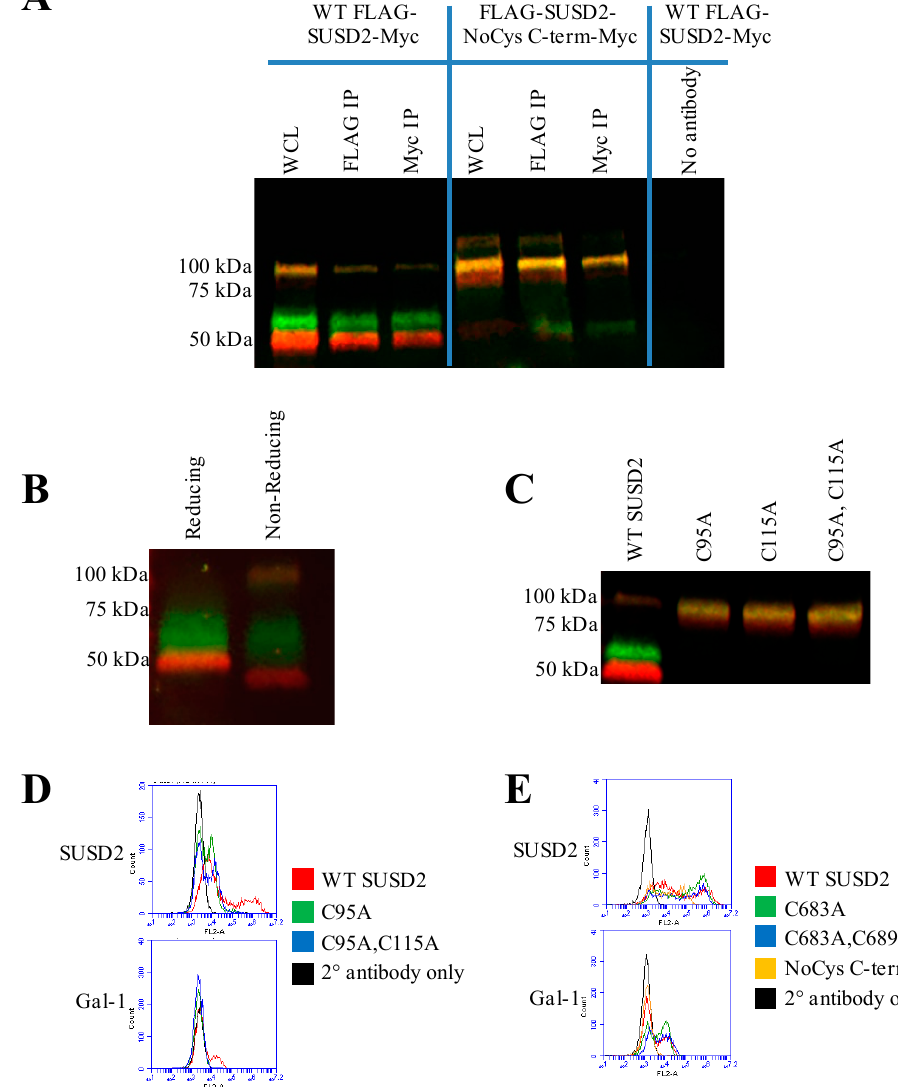
Figure 5. Immunoprecipitation and flow cytometry analysis of FLAG-SUSD2-Myc. ( A ) 293T cells were transfected with either pFLAG-SUSD2-myc or pFLAG-SUSD2-NoCys C-term-myc. Whole cell lysates (WCL) were immunoprecipitated with anti-FLAG or anti-Myc antibodies. Western immunoblot analysis using anti-N-terminal (red) and anti-C-terminal (green) SUSD2 antibodies was performed. Yellow indicates the presence of the full-length SUSD2 polypeptide. WCLs were used as a positive control. ( B ) SUSD2 precursor polypeptide present under nonreducing conditions. Western immunoblot analysis of SUSD2 from SKBR3 WCL was performed under reducing and nonreducing conditions. For nonreducing conditions, β -mercaptoethanol was omitted from the loading bu ff er. Antibodies used for western immunoblot analysis are the same as above in ( A ). ( C ) SUSD2 C-terminal cysteine to alanine mutations inhibited cleavage. Western immunoblot analysis was performed on 293T cells transiently transfected with plasmids encoding FLAG-SUSD2-Myc N-terminal single cysteine mutants, C95A and C115A, as well as the double mutant C95A and C115A. Anti-N-terminal (red) and anti-C-terminal (green) SUSD2 antibodies were used. Flow cytometry analysis of SUSD2 N-terminal ( D ) and C-terminal ( E ) cysteine mutants. 293T cells were transiently transfected with plasmids encoding WT SUSD2 or SUSD2 cysteine mutants as indicated. After 48 h, cells were labeled with anti-SUSD2 or anti-Gal-1 antibodies and analyzed for surface staining using the Accuri C6 flow cytometer. WT SUSD2 was used as a positive control, and 2 ◦ antibody was a negative control. Since disulfide bonding of the SUSD2 fragments was necessary for cleavage and surface localization, we hypothesized that the mature form of SUSD2 is a disulfide bonded heterodimer of